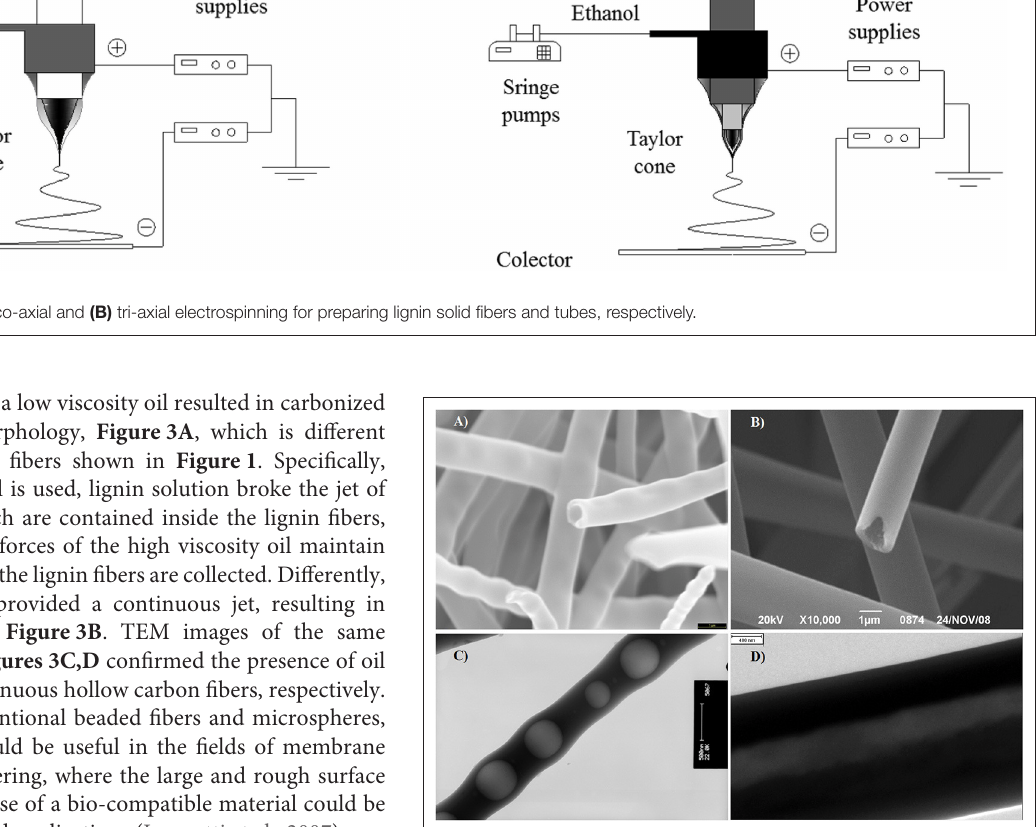
FIGURE 3 | SEM images of carbonized electrospun lignin fibers obtained using (A) a low viscosity oil; and (B) high viscosity oil. Bar lengths: 1 µ m. TEM images of the same carbonized electrospun lignin fibers obtained using (C) the low viscosity oil (bar length: 500nm); and (D) the high viscosity oil (bar length: